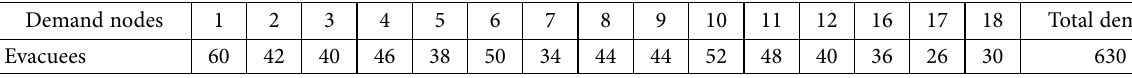
Table 2. Demand values at each demand